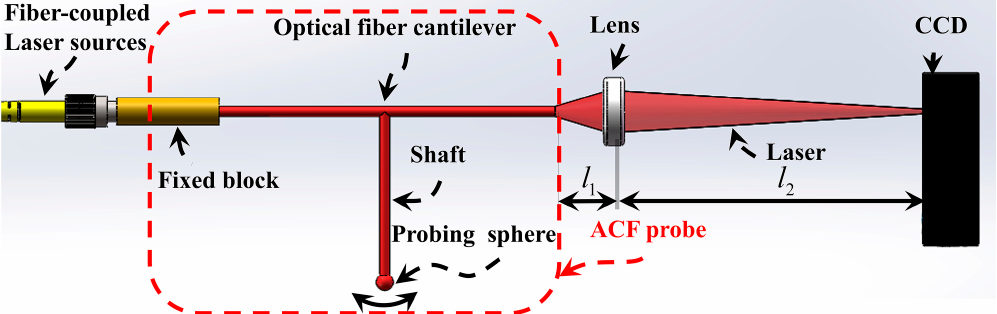
Figure 1. Structure and measurement principle of the assembled cantilever fiber (ACF) probe.